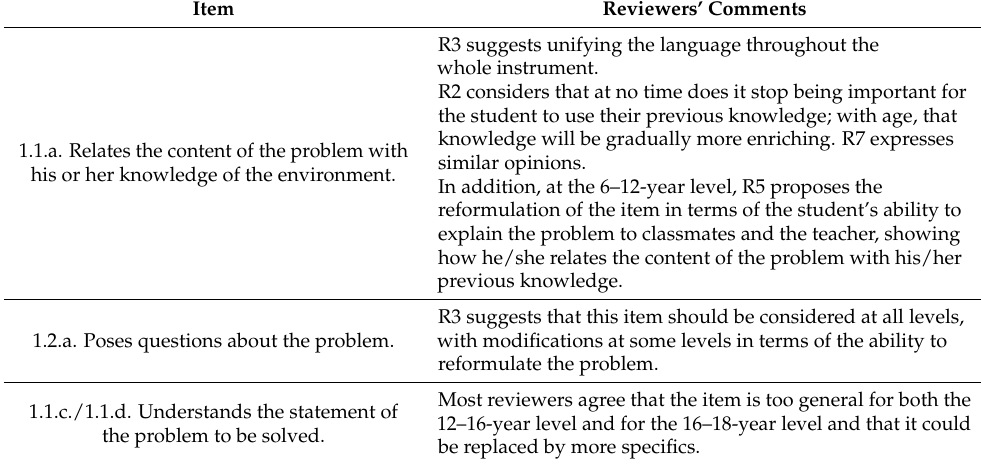
Table 1. Comments on